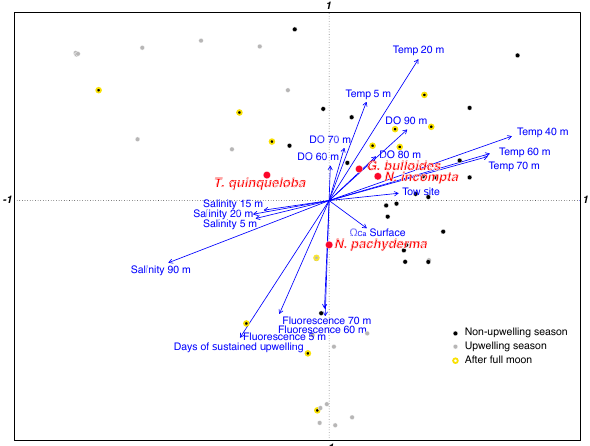
Figure 5. Biplot of canonical correspondence analysis of relative abundance of the four most abundant species compared with envi- ronmental variables at the time of collection for all tows in which foraminifera were found. Dominant species are represented by large red points, and small points represent individual tows. Grey points are tows that fall within upwelling season, as shown in Fig. 2, and black points outside of this season. Points with a golden halo repre- sent tows during lunar days 14–18.